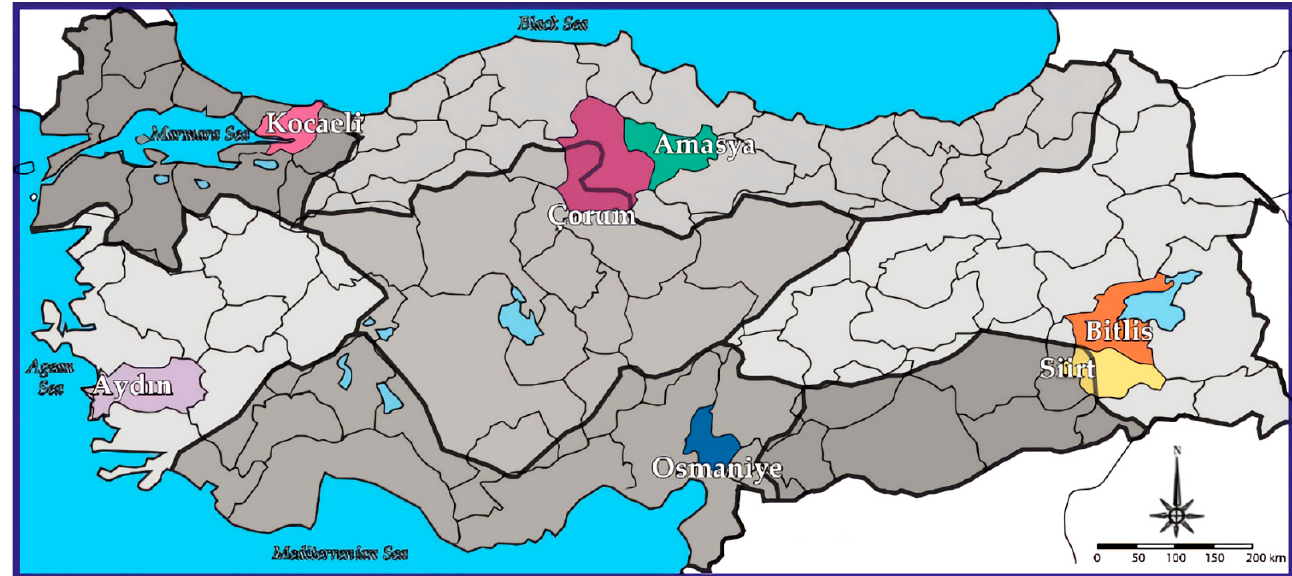
Figure 14. Settlements considered in the study. Kocaeli (Marmara region), Bitlis (Eastern Anatolia region), Aydın (Aegean region), Siirt (Southeast Anatolia region), Amasya (Black Sea region), Çankırı (Central Anatolia region) and Osmaniye (Mediterranean region) provinces are located in the same earthquake zone. A random geographic location was chosen from each of the centers. For these settlements, earthquake parameters were obtained with the help of TEHMIWA, considering four different ground motion levels with different exceedance probabilities. Different earthquake ground motion levels specified in TBEC-2018 are given in Table 3 to be considered in this study. In the previous regulation, TSDC-2007, only the standard design ground motion level, which has a 10% probability of being exceeded in 50 years, used to be taken into account.